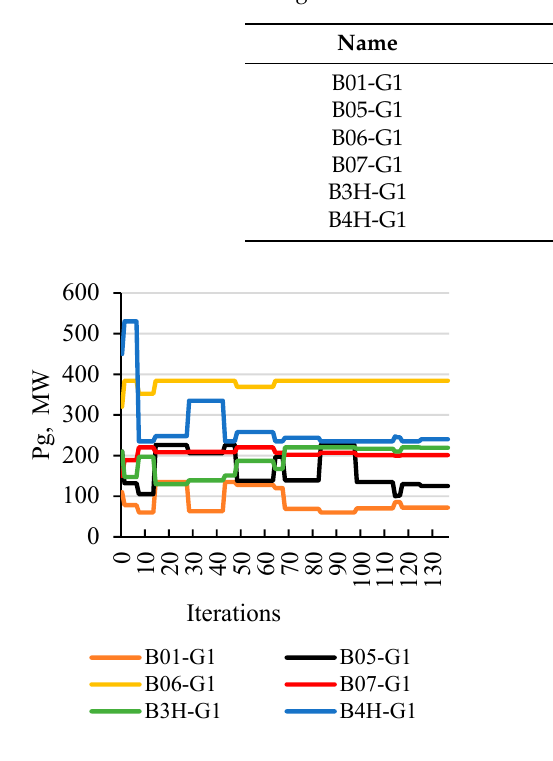
Table 5. List of sources with optimal capacity and expected values of power surges calculated for each generator.